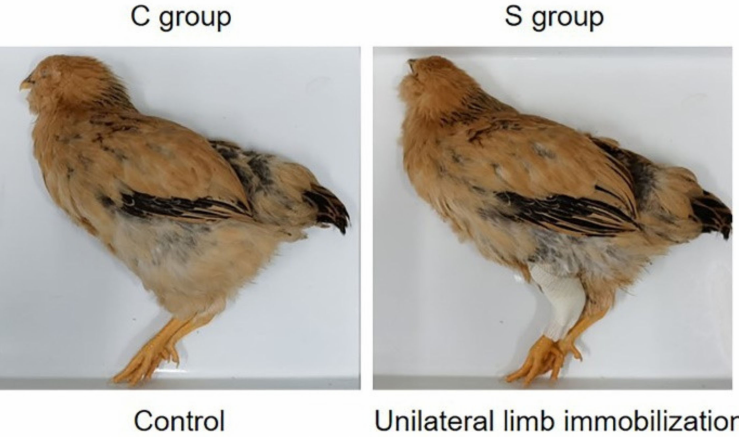
Figure 7. Schematic diagram of disuse muscle atrophy